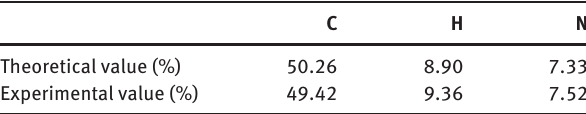
Table 1 Results of element analysis of monomer.